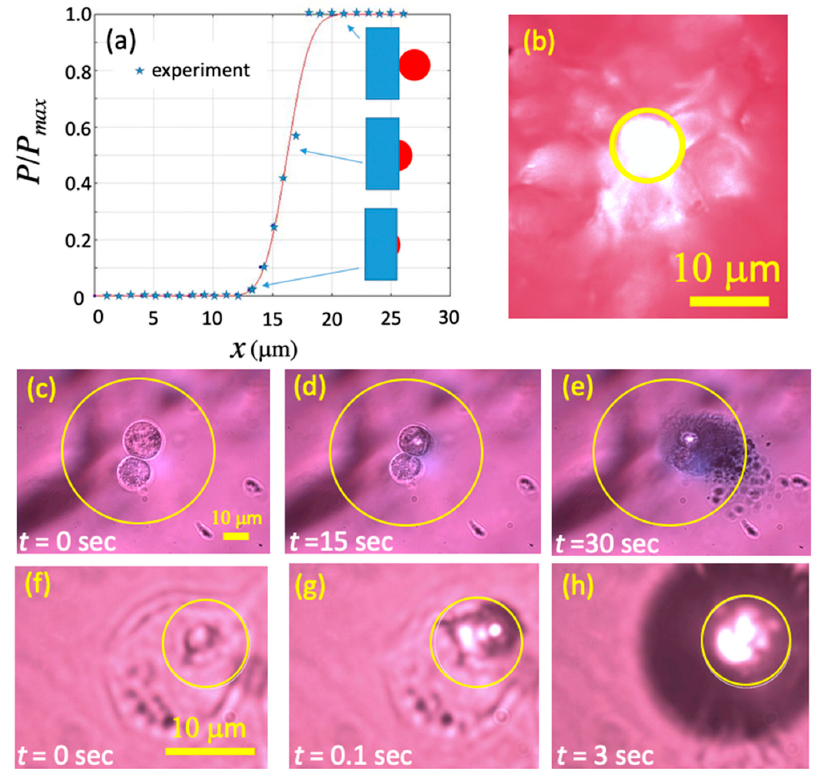
Figure 5. ( a ) Optical power (scaled to its maximum) versus position, measured using the blade edge shading effect. The insets sketch approximate blade-beam relative locations at selected points. ( b ) Optical image of the laser spot obtained by using the fluorescent card. ( c – e ) Images of two VM-M3 cells moderately filled with mNPs, at various exposure times to laser light, at 10× magnification (light power density ∅ i nc ≈ 6 × 10 7 W m − 2 ). ( f – h ) Images of a VM-M3 cell moderately filled with mNPs, at various exposure times to laser radiation, at 100× magnification (power density ∅ inc ≈ 1.4 × 10 9 W m − 2 ). Yellow circles mark approximate beam diameter, which changes with magnification.